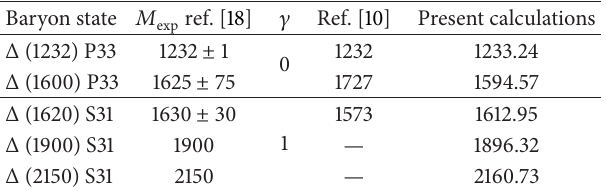
Table 3: The present calculations of Δ baryon states in comparison with the Cornell potential results [10] and the experimental data [18] in (MeV).